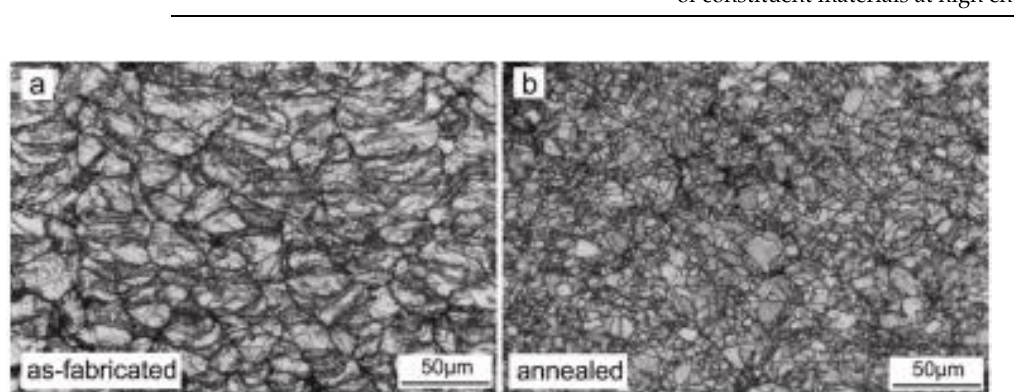
Figure 20. Comparison of microstructure of CSAM part ( a ) without and ( b ) with heat treatment (annealing) [3].